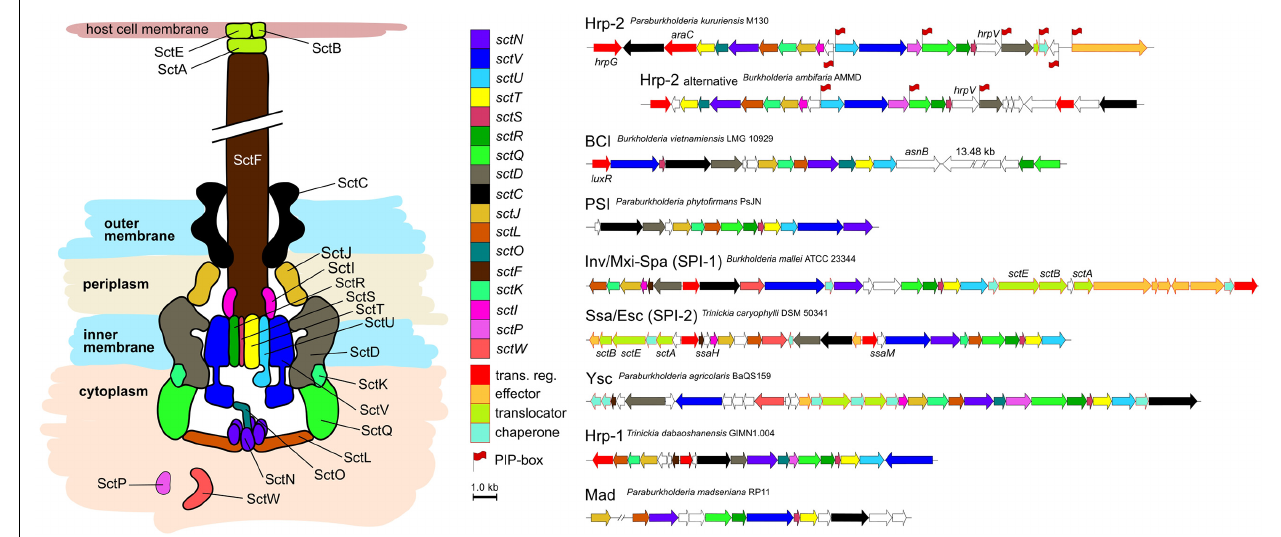
FIGURE 2 | Schematic overview of the T3SS and synteny of coding regions Burkholderia s.l. species. Seven different major types of injectisomes are found in Burkholderia s.l. species. They can be distinguished by their genetic proximity but also by the chromosomic organization of their coding region as depicted here. These regions vary in size and composition while a subset of 12–13 core components is ubiquitously present ( sctO is absent in PSI, SPI-1, and SPI2; sctK is absent in Hrp1). Secretion and cellular translocation genes have an individual color code with a black outline. Further genes involved in transcription or coding for effectors, their translocators and chaperones are depicted with a red outline. Genes without sct nomenclature or with unknown functions are left blank. Red flags at gene beginnings indicate the presence of a PIP-box regulation sequence in the region preceding the